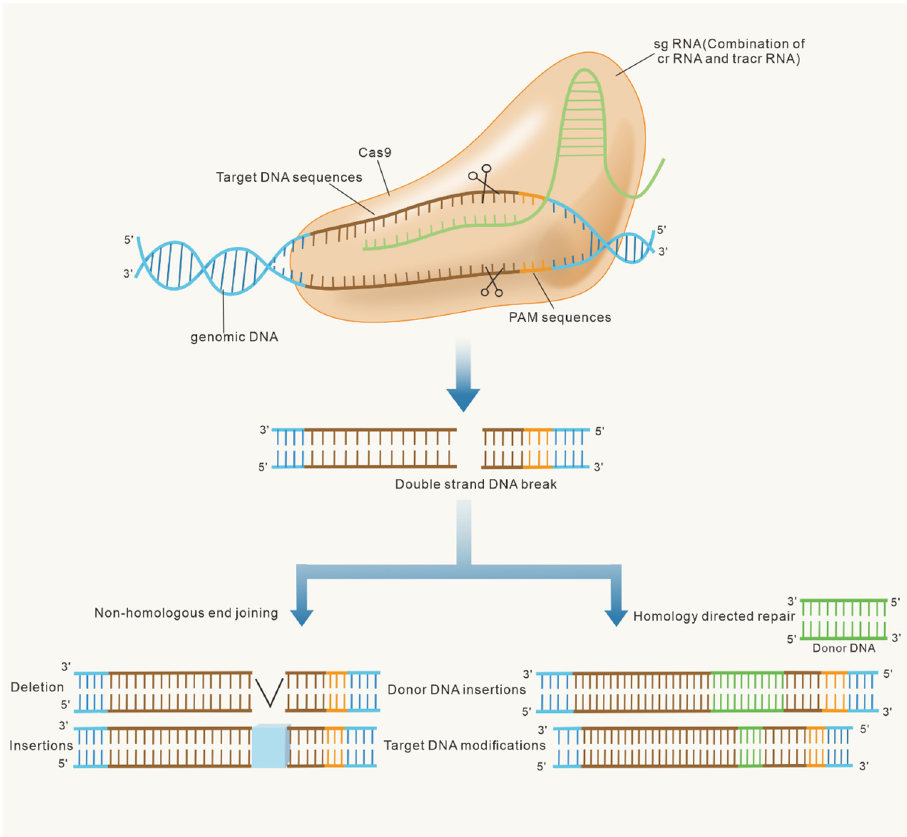
Figure 2. Genome editing at the CRISPR/Cas9 target locus. Site-specific nucleases introduce double- strand breaks where genes are modified by two repair pathways. Non-homologous end joining (NHEJ) knocks out genes via deletions or insertions in the absence of donor DNA. Homology-directed repair (HDR) results in the insertion of donor DNA on the basis of homologous regions and the correction of gene sequences according to small changes in either DNA strand.